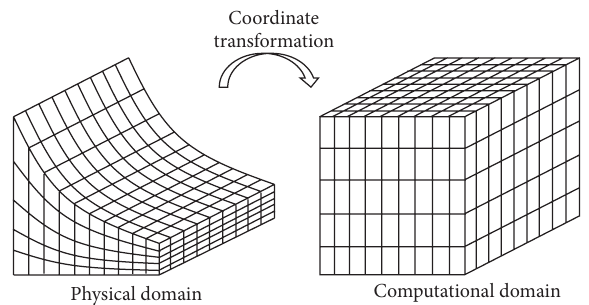
Figure 3: Transformation from physical to computational domain.